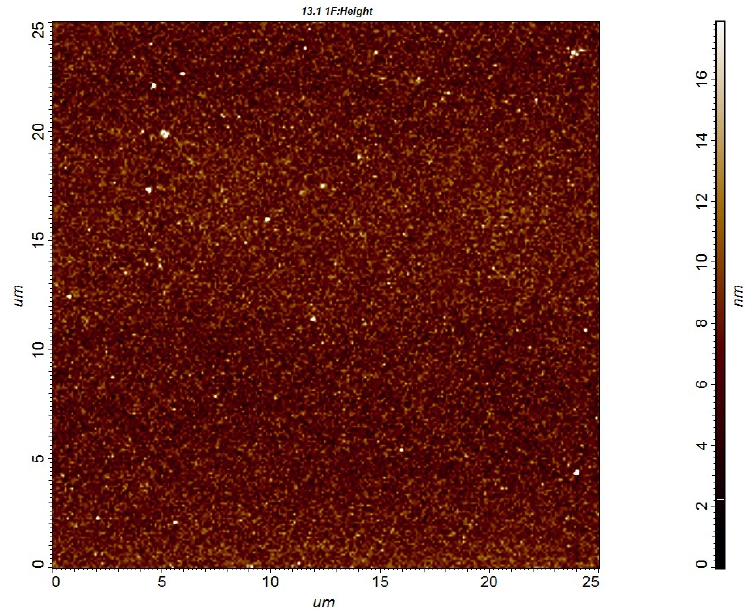
Figure 10. Typical AFM image of SiCN sample.